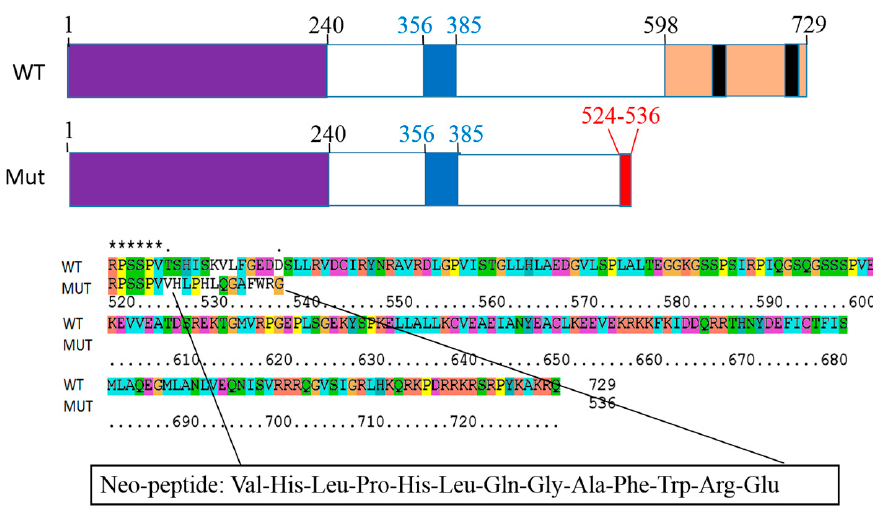
Figure 2. Functional domain of the Bap1 protein: domain in purple: ubiquitin C-terminal hydrolase, domain in blue: HCF-binding motif, domain in peach: nuclear localization; the sequence of neoORF (red: 524th–536th aa is the sequence of the 13-mer neo-peptide); * asterisk: same acids in both sequences.